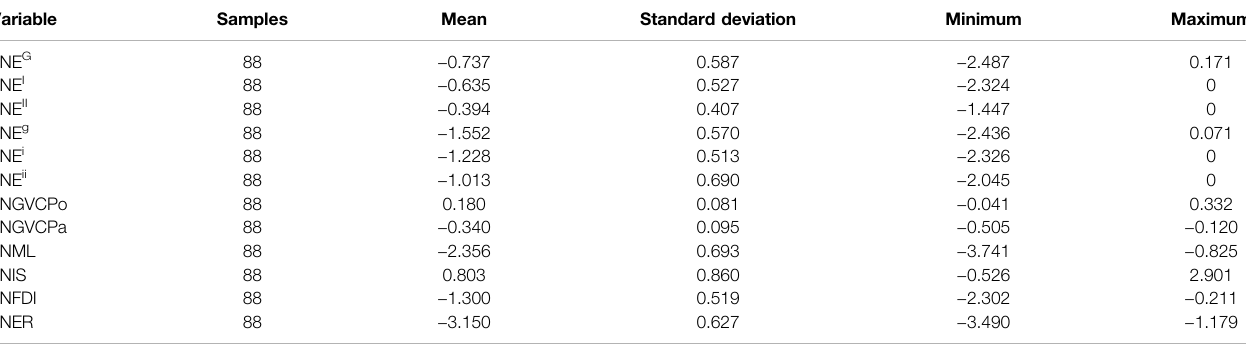
TABLE 1 | Descriptive statistics of each variable.